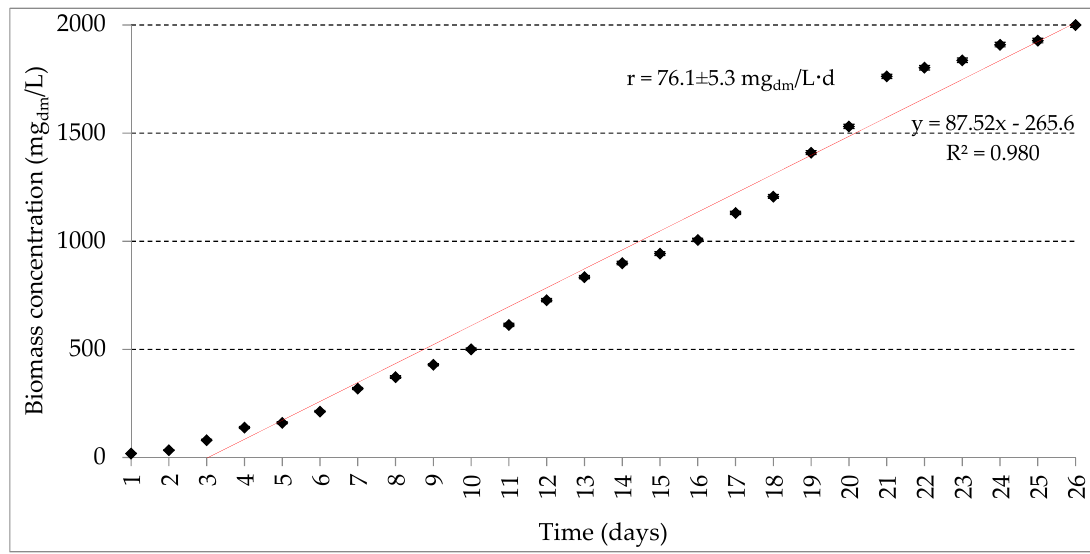
Figure 2. Microalgae biomass production over the cultivation time in stage 1.